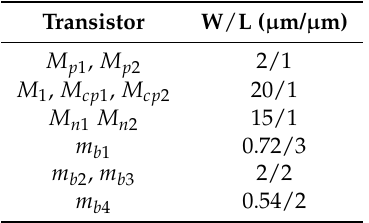
Table 1. Transistors aspect ratios for the proposed buffer.